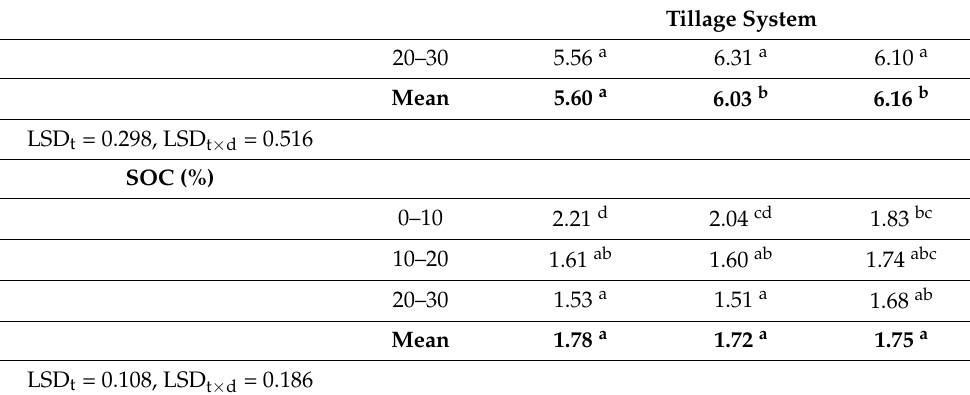
LSD t = 0.108, LSD t×d = 0.186